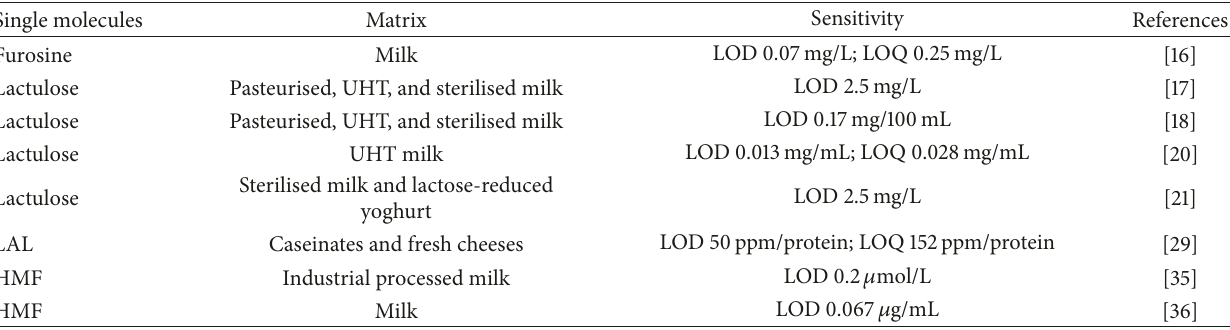
Table 1: Limit of detection (LOD) and limit of quantification (LOQ) in some thermal treatment indicators according to nonreference